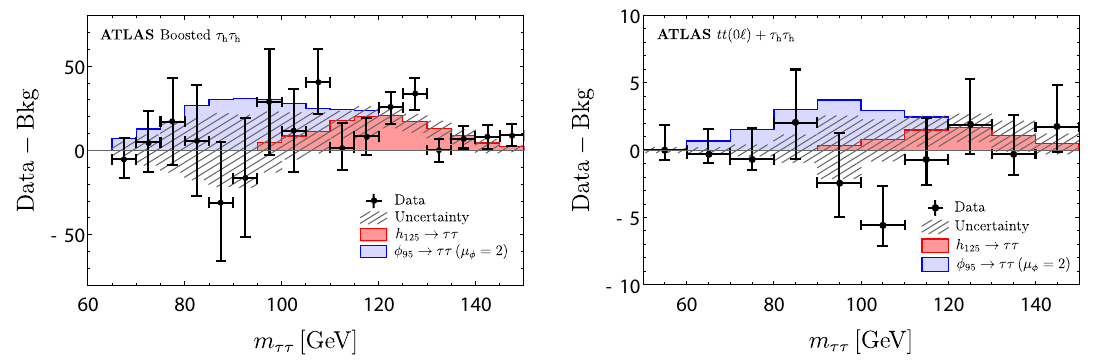
τ ( 0 (cid:8)) + τ τ τ h h and the right panel is the tt h h categories, respectively. The signal normalization is assumed to be μ φ = 2, and m φ = 95GeV are set for the mass. See the text for